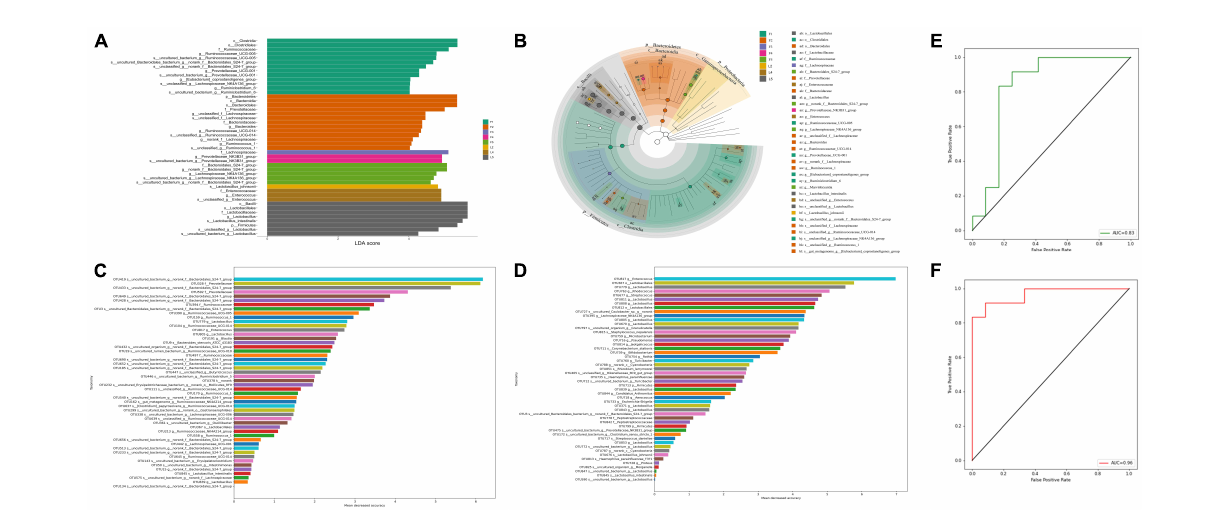
FIGURE6 Linear regression analysis between bacterial community structure and function. (A) Linear discriminant effect size (LEfSe) analysis of microbial communities in feces and ileum samples with linear discriminant analysis (LDA) scores indicating significant differences in the microbiota among separate groups. (F1 represents LRIF group, F2 represents HRIF, F3 represents LR, F4 represents HR, and F5 represents control in feces; L2 represents HRIF, L4 represents HR, and L5 represents control in ileum). (B) Cladogram indicating the phylogenetic distribution of microbiota correlated with the feces and ileum groups. (C) Top 50 important biomarkers selected by random forest analysis in feces. (D) Top 50 important biomarkers selected by random forest analysis in ileum. The horizontal axis is the measurement standard of variables of importance, and the value is equal to the measurement value of variables of importance/standard deviation. The vertical axis is the variable names sorted by importance. (E) ROC curve (AUC) of gut-microbiota-based classification. Random forest classifiers were used to separate five groups in feces based on the OTU-level gut microbiome composition. (F) ROC curve (AUC) of gut-microbiota-based classification based on the random forest to separate five groups in ileum. The AUC value is the area under the corresponding curve. The diagnostic effect is better when the AUC > 0.5 and the AUC value is closer to